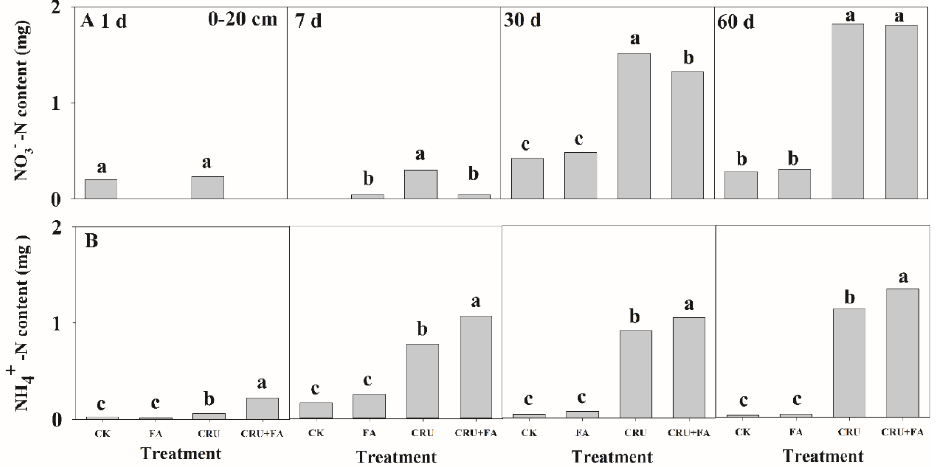
Figure 5. The nutrient change: NH 4+ -N content (ammonium nitrogen content, ( A ) and NO 3 − -N content (nitrate nitrogen content, ( B ) after adding FA from leaching solution. Treatments or treatment components: CK (Control no added fertilizer); FA (fulvic acid 90 kg ha − 1 ); CRU (N from controlled-release urea 450 kg ha − 1 ); CRU+FA (N from controlled-release urea 450 kg ha − 1 , fulvic acid 90 kg ha − 1 ). Within each graph, means followed with the same letter were not significantly different based on a one-way ANOVA followed by Duncan’s multiple-range test ( p >